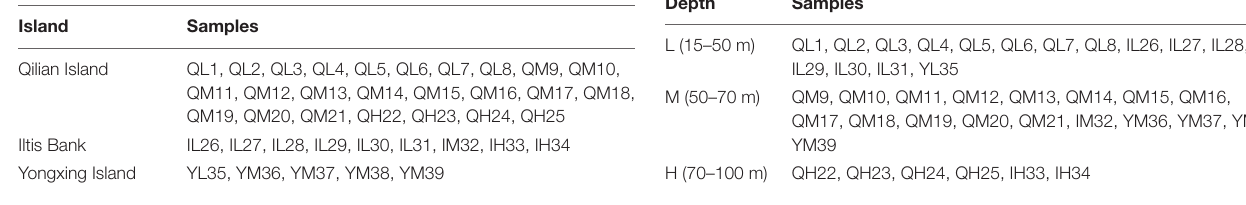
TABLE 2 | Samples from different islands.